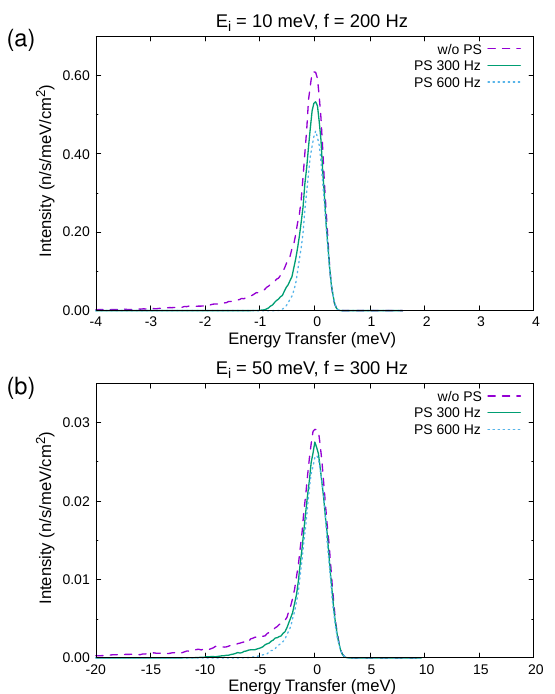
Figure 6. Energy-transfer spectra without and with the pulse shaping chopper obtained by Monte Carlo simulations. The sample is the same vanadium as used in the calculations of Fig. 3. (a) E i = 10meV and f = 200Hz. (b) E i = 50meV and f = 300Hz. Broken, solid, and dotted lines denote spectra with- out the pulse-shaping chopper, with the pulse-shaping chopper rotating at 300Hz and at 600Hz,